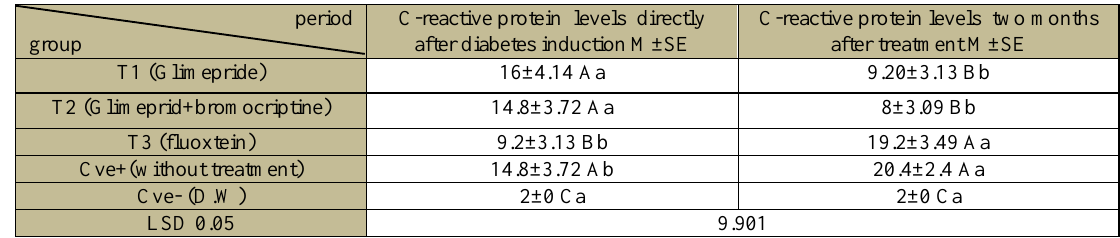
Table ,2: C- Reactive protein level mg/ml in induced diabetic rabbit groups dosed orally for two months with glimepride ,bromocriptine and fluoxtein